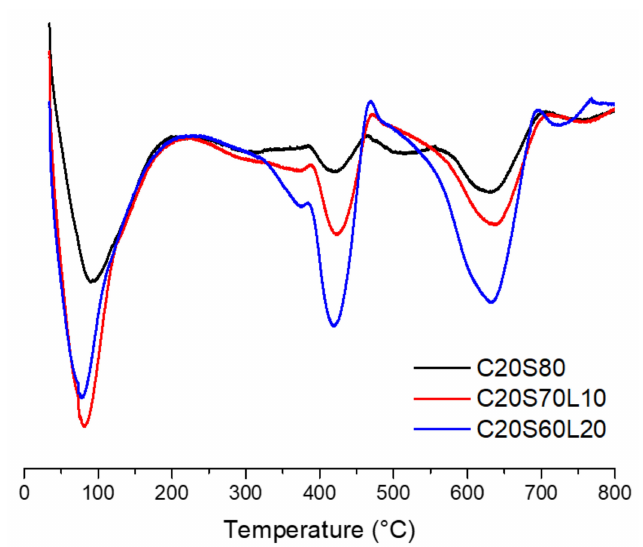
Figure 11. DTG curves of 20% OPC-based AAS mixtures with increasing LBD content.